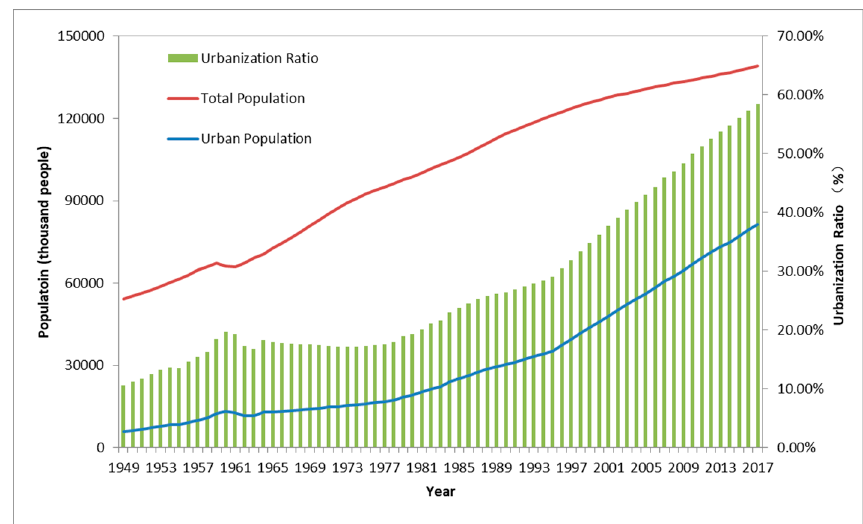
Figure 1. The population and urbanization ratio of China [7].